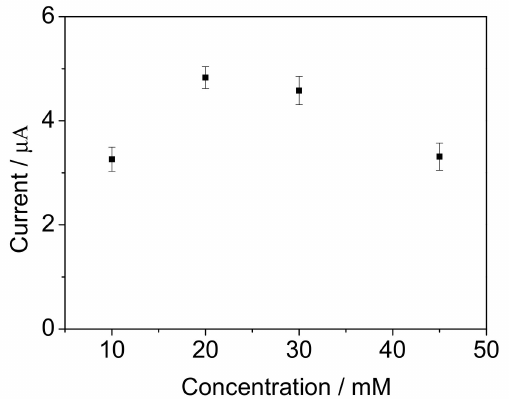
Figure 11. The influence of ferricyanide concentration on the current response for 10 mg/L BOD standard solution. The error bars represent three replicate